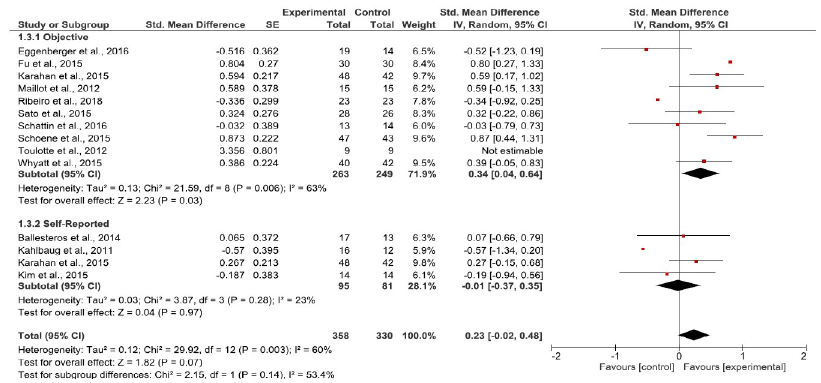
Fig 3. Forest plot of comparisons: Experimental vs. control group change in physical